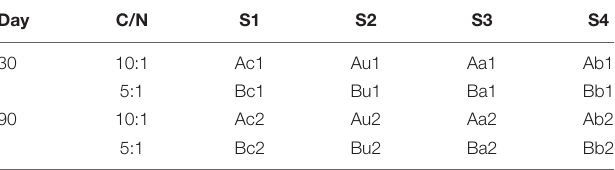
TABLE 1 | Locations of different sampling points in